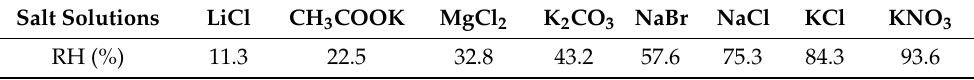
Table 1. Saturated salt solutions and the registered relative humidity at 25 ◦